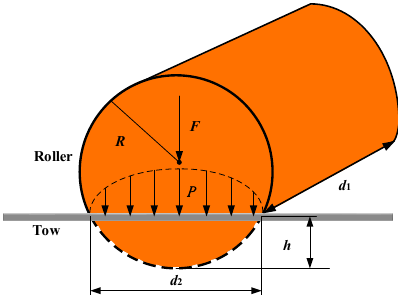
Figure 4. Schematic diagram of the Hertz contact.